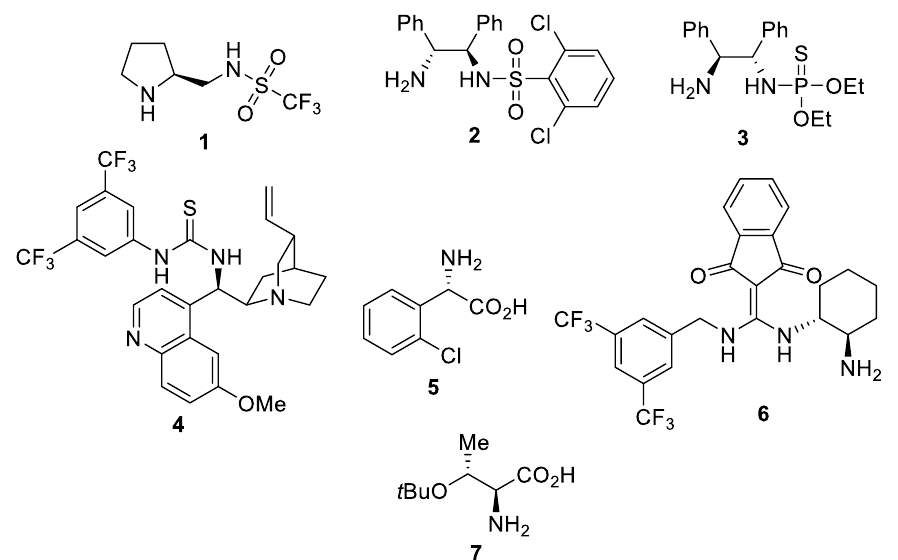
Figure 1. Organocatalysts employed in the asymmetric conjugate addition of ketones to maleimides.